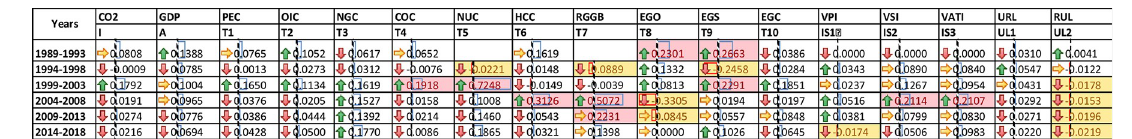
Fig 9. Percentage change of indicators. Note: Variable’s definition stated in Table 1.